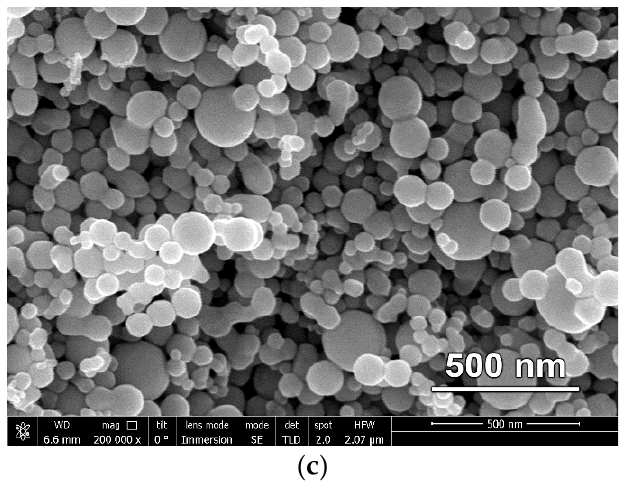
Figure 1. ( a ) Sample of the pressed nNi. ( b ) Microstructure of the pressed nNi. The circle illustrates the approximate size of the VISAR monitoring point. ( c ) Nanostructure of the pressed nNi. Table 1. Parameters of experiments.